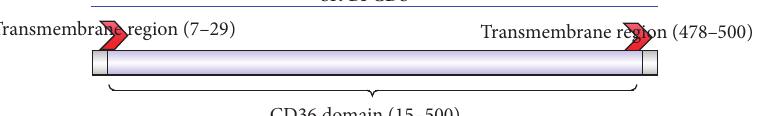
Figure 1: A schematic representation of the MnSR-BI protein complete CDS (514 amino acids), the blue part representing the CD36 domain, and the two transmembrane regions were at the N- and C-terminals of the